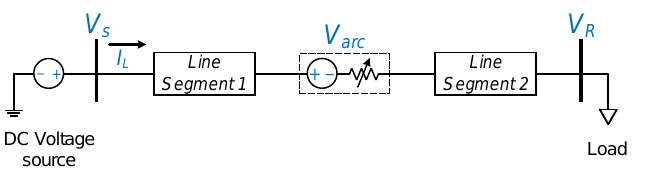
Figure 2. Simplified circuit representation of a dc line in the presence of a series arc